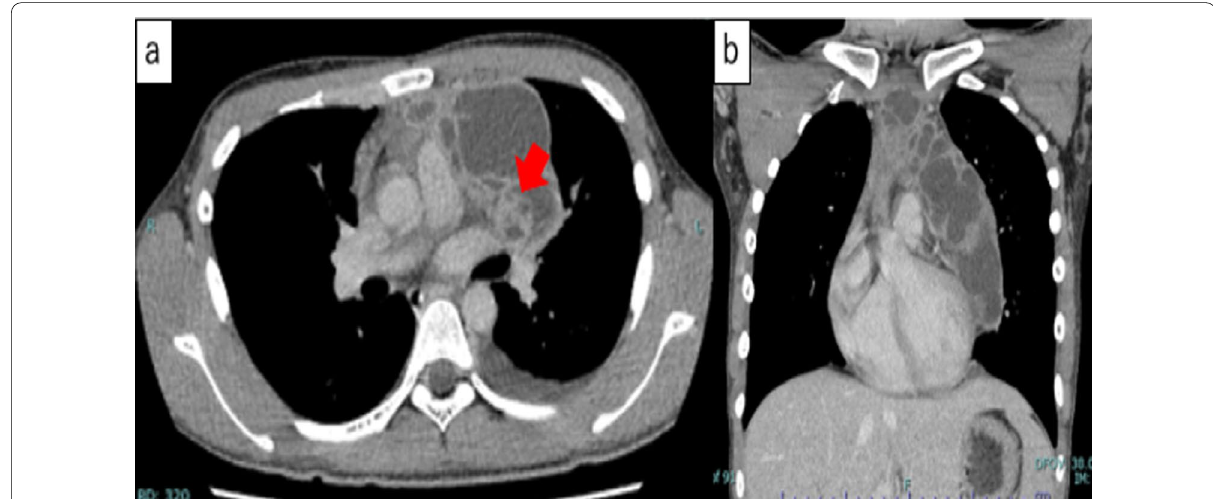
Fig. 2 Enhanced CT revealed a multilocular heterogenous giant cyst superior to the anterior mediastinum. Septations with irregular wall thickening and a solid component (red arrow) were observed in the cyst, which had slightly higher CT attenuation than